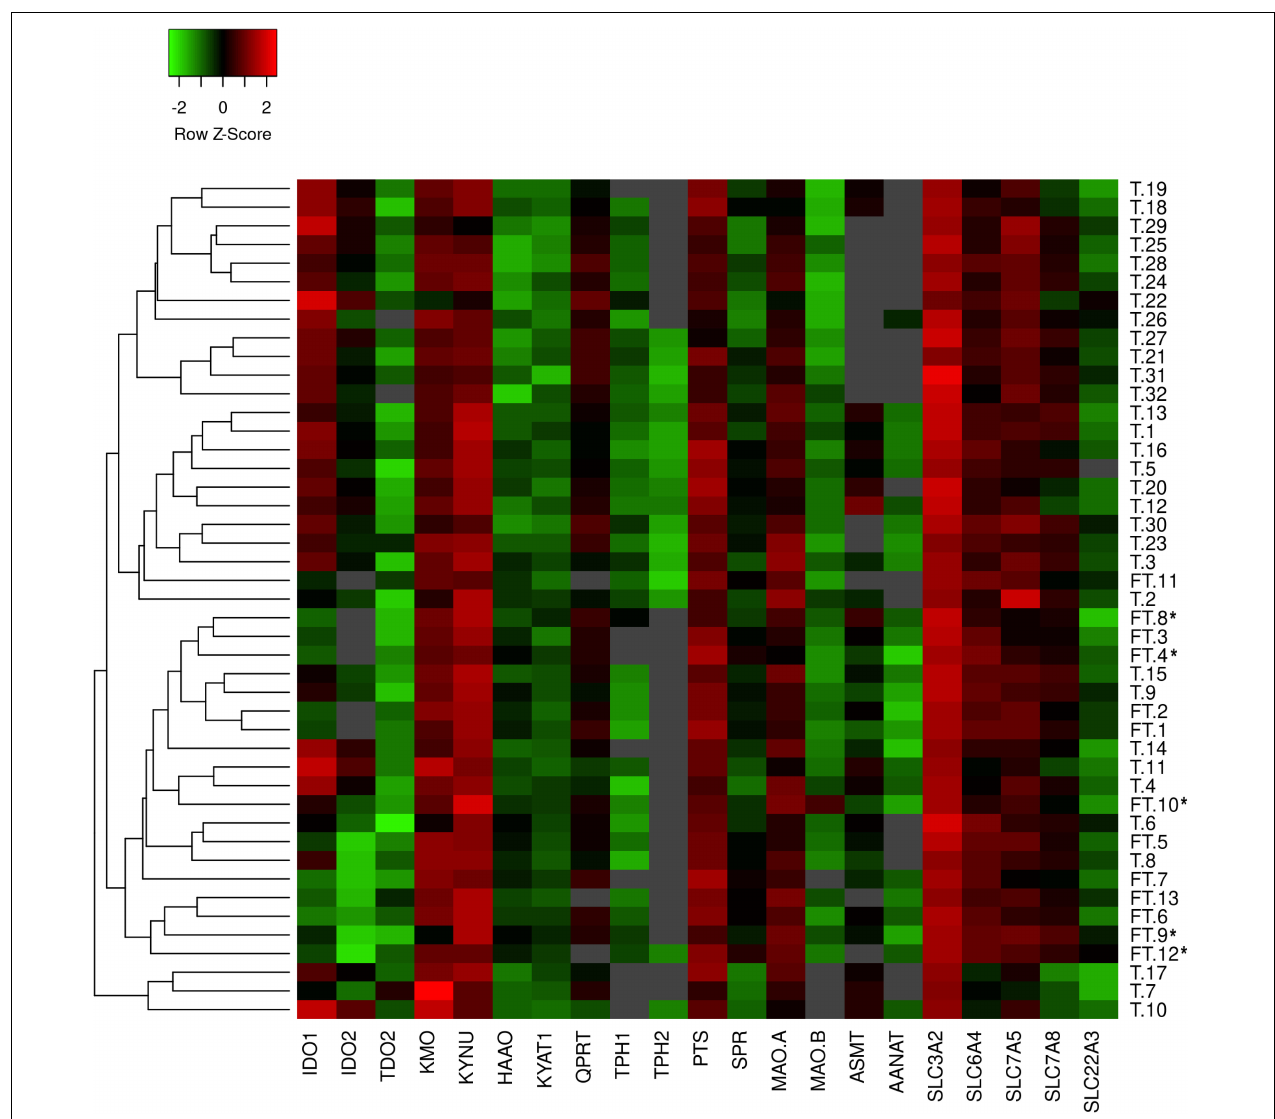
FIGURE 1 | Heatmap generated from qPCR gene expression analysis of TRP pathway in human placenta. Expression of 21 key transporters/enzymes was analyzed in first trimester (FT; n = 13) and term (T; n = 32) human placenta samples. Hierarchical clustering (average linkage, Euclidean distance) was applied to group samples with similar expression levels, emphasizing the overall changed expression during gestation. The color intensity indicates expression levels; red: up-regulation, green: down-regulation, gray: not detected. *Placentas from